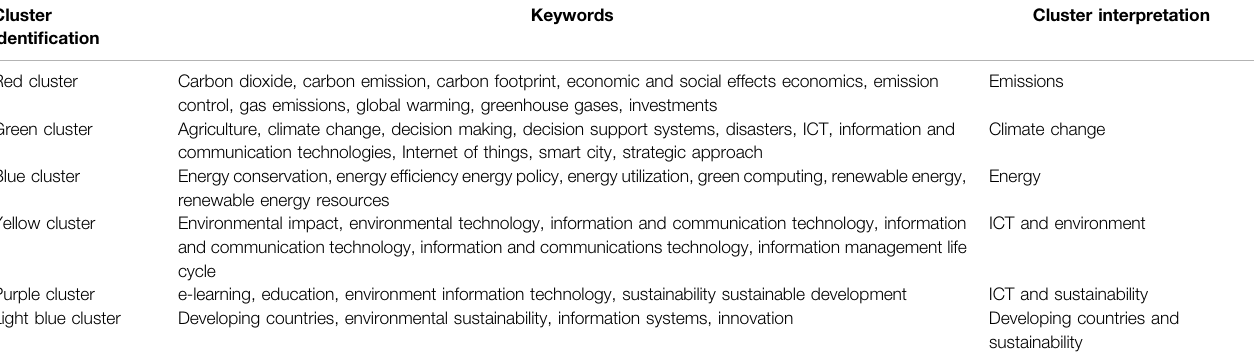
TABLE 3 | VOSviewer clusters " ’ ICT and climate change". Cluster identi fi